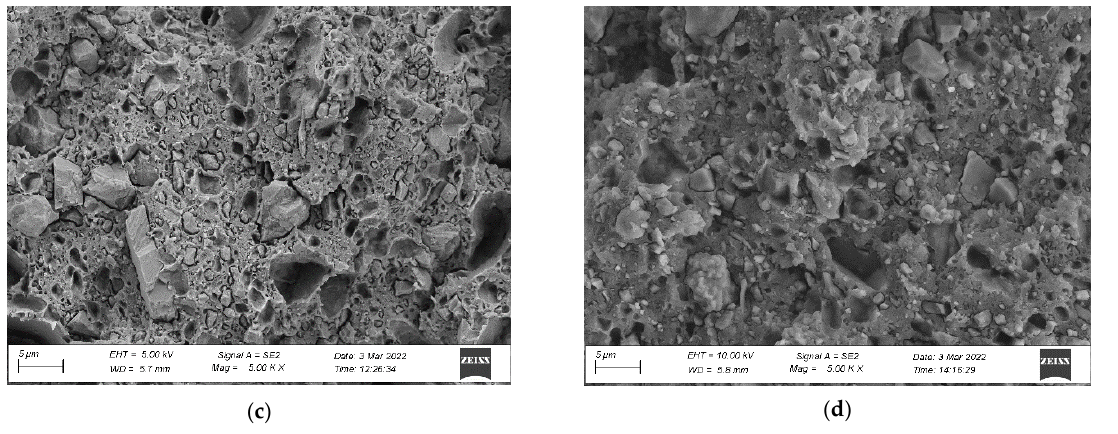
Figure 3. Microstructure of fracture surface, at 200× magnification, obtained for ( a ) RO primary material, ( b ) RZ secondary material and at 5000× magnification, obtained for ( c ) RO primary material, ( d ) RZ secondary material.